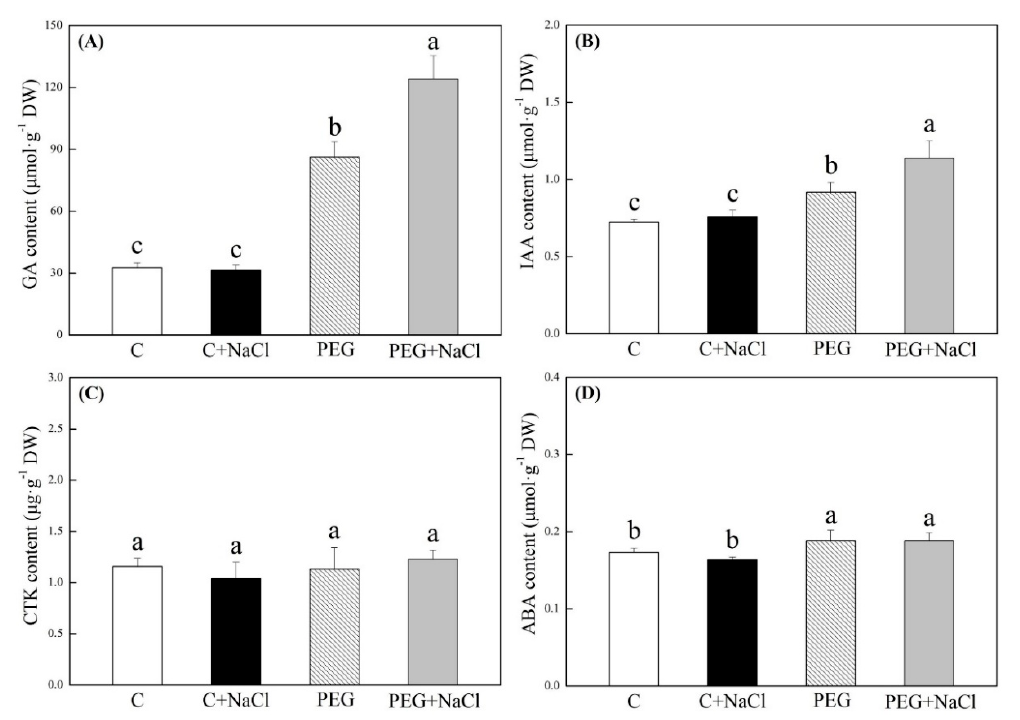
Figure 2. Effects of seeds soaking with water or NaCl (1 mM) on ( A ) gibberellin (GA) content, ( B ) indole-3-acetic acid (IAA) content, ( C ) cytokinin (CTK) content, and ( D ) abscisic acid (ABA) content after seven days of germination under normal conditions and water stress induced by 19% polyethylene glycol (PEG) 6000. Vertical bars indicate ±SE of the mean ( n = 6). Different letters above columns indicate significant differences ( p ≤ 0.05).